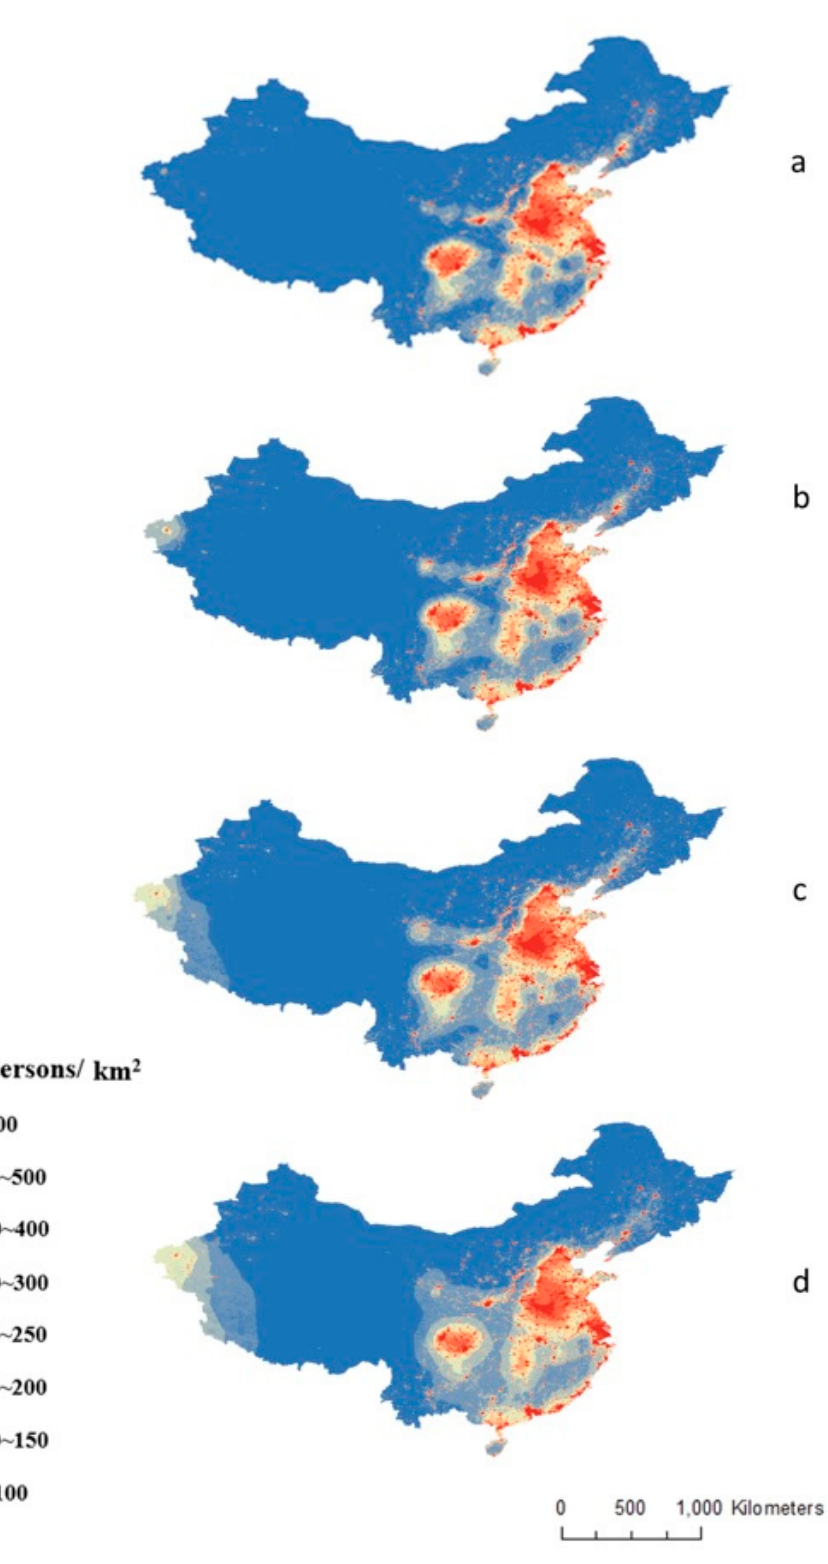
Figure 6. Bandwidth adjustment iteratively in ANNGWR, e.g., the bandwidths are ( a ) 0.01, ( b ) 0.05, ( c ) 0.1, and ( d ) 0.2.